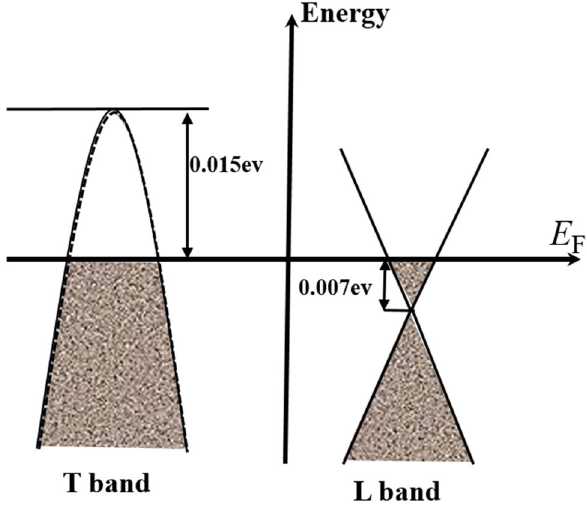
Figure 5. The position of the Fermi level at the T and L bands deduced from the SdH oscillations analysis, and new modified two-band model